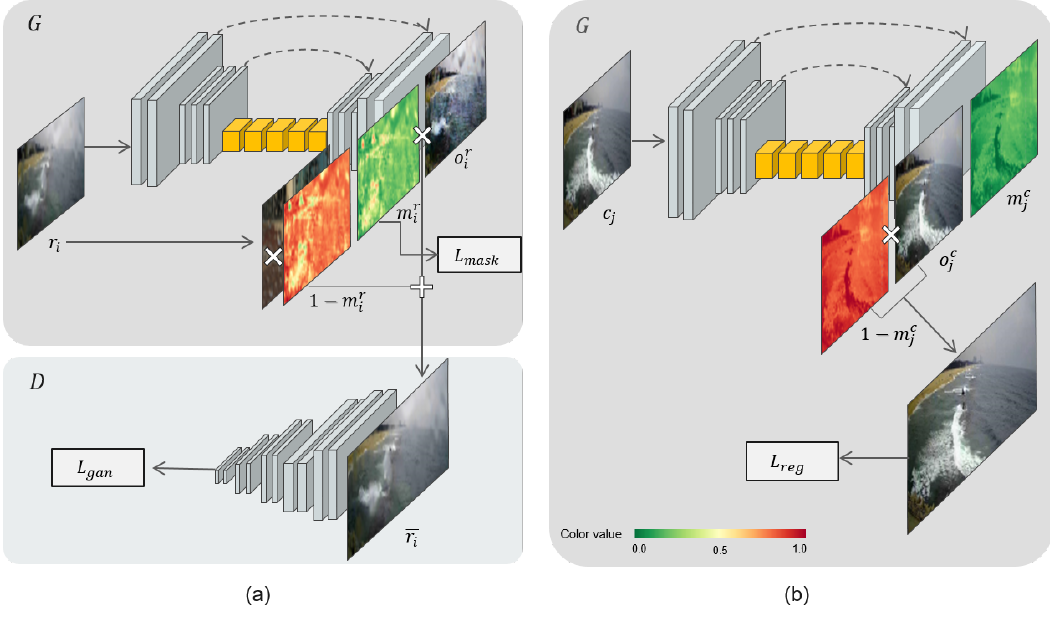
Figure 2. Forward propagations of the input in the scene generator of Raindrop-aware GAN when computing ( a ) the loss functions L mask and L gan for the sparse mask and adversarial learning, respectively; and ( b ) the loss function L reg for background